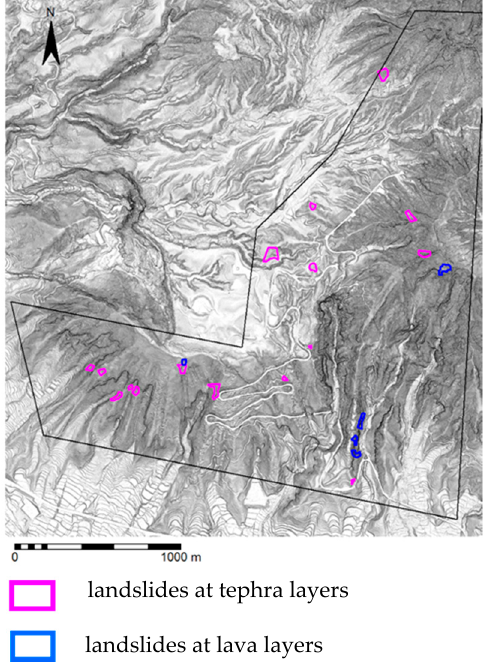
Figure 3. The distribution of landslides triggered by the 2016 Kumamoto earthquake. The landslides are categorized into two types: In pink—landslides at tephra layers; in blue—landslides at lava layers.